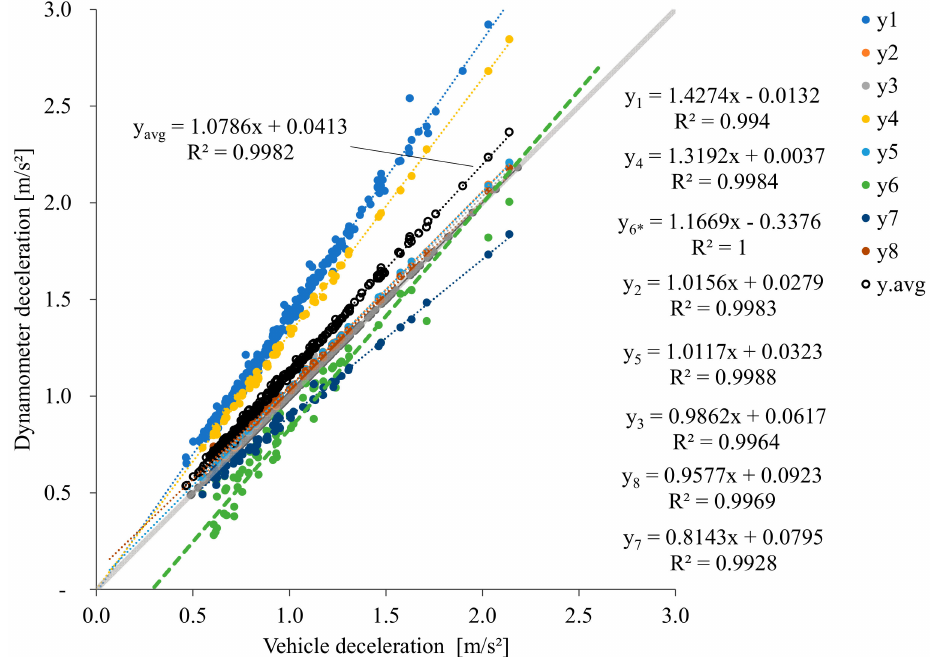
Figure 4. Deceleration by event for each lab (T1-R1), the vehicle, and the overall average. The solid grey line identifies the ideal regression line (vehicle). The dataset with a regression line y avg = 1.0786x + 0.0413 indicates the general average excluding Lab